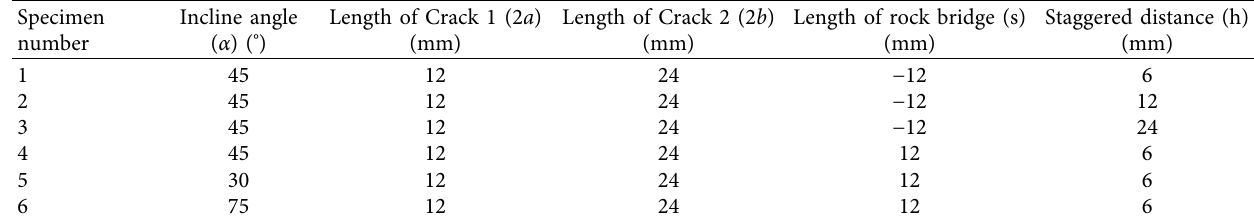
Table 5: Geometric parameters of cracks in specimens.